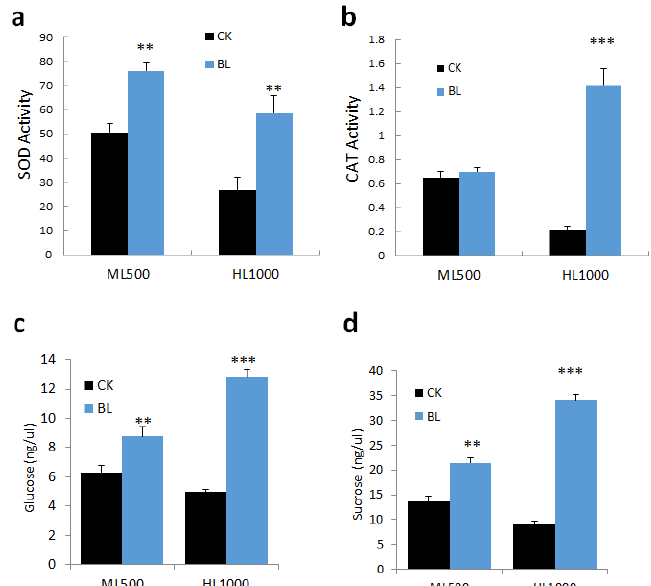
Figure 7. Blue-light-acclimation altered ROS accumulation, antioxidative enzyme activity, and sugar content after exposure to high irradiation. ( a ) Superoxide dismutase (SOD) activity. ( b ) Catalase (CAT) activity. CAT, catalase activity (mU/mL). ( c ) Glucose content. ( d ) Sucrose content.